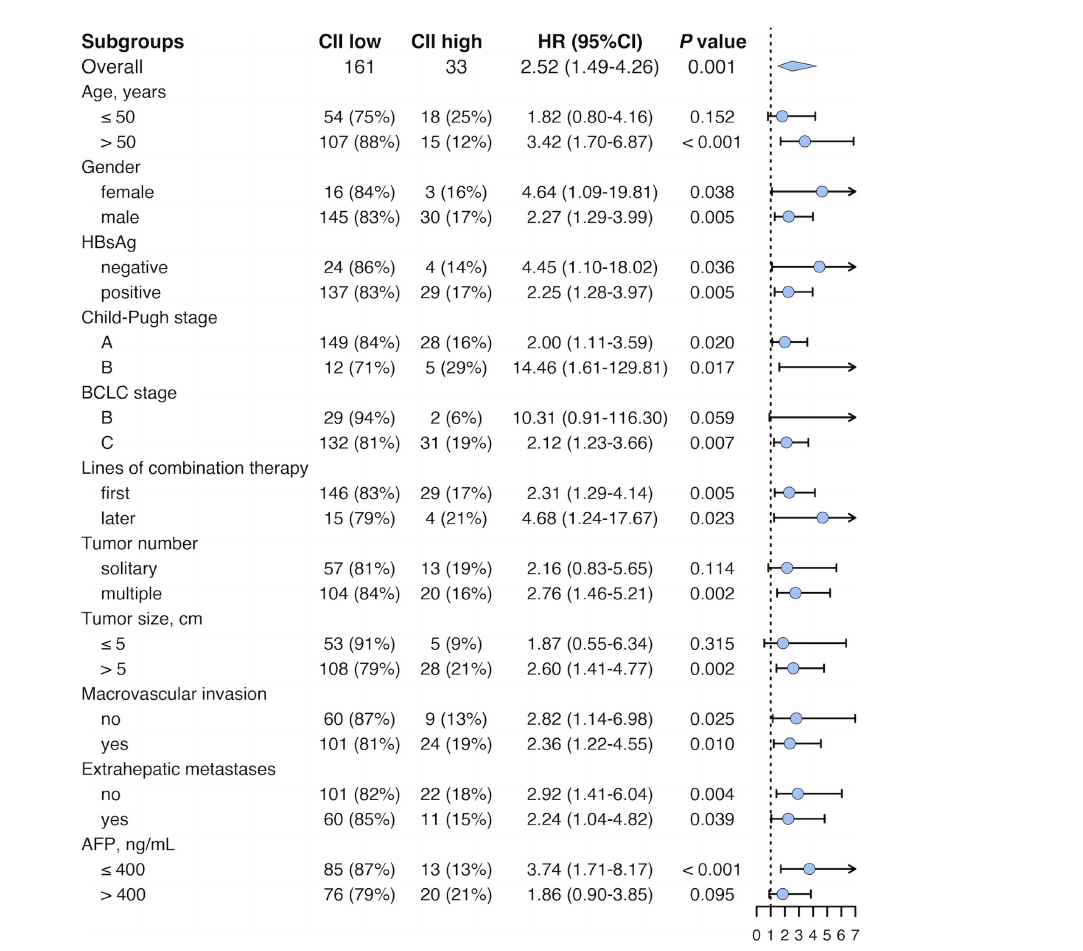
FIGURE 3 Forest plot of HR for survival in different subgroups in the pooled cohort. HR, hazard ratio; CII, circulating immune index; CI, con fi dence interval; HBsAg, hepatitis B surface antigen; BCLC, Barcelona Clinic Liver Cancer; AFP,